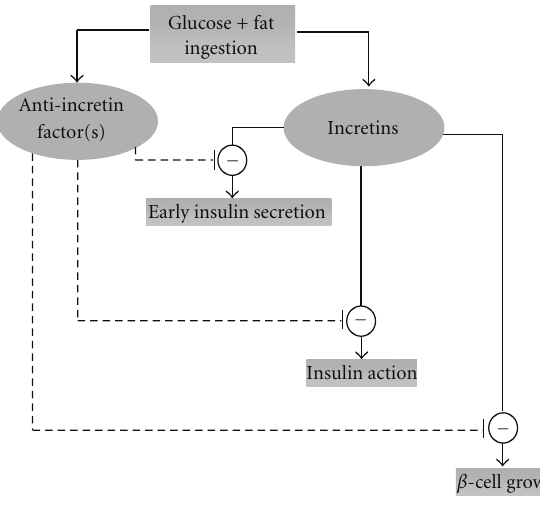
Figure 7: Anti-incretin